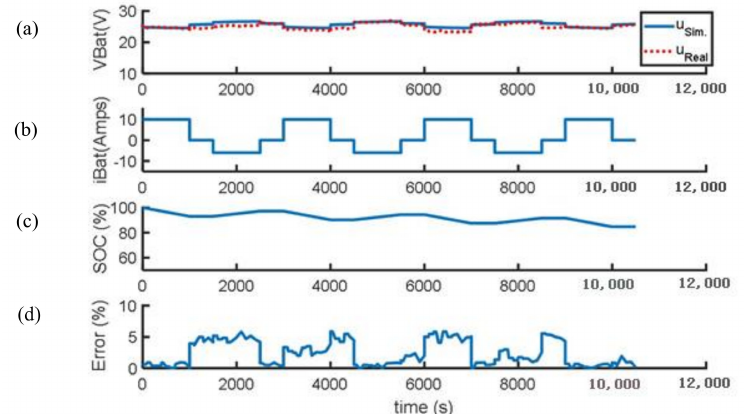
Figure 8. Battery model validation during the charging and discharging process. ( a ) battery voltage; ( b ) battery current; ( c ) battery SOC ; ( d ) calculated error between measured data and simulation.